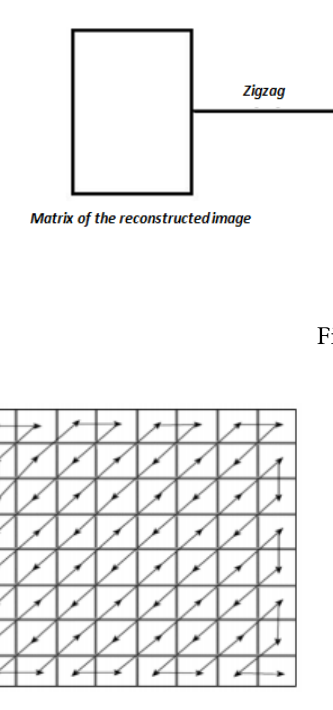
Figure 5: Zigzag